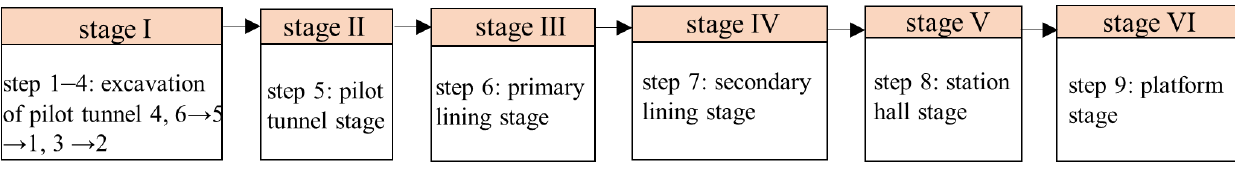
Figure 8. Simulated construction steps.